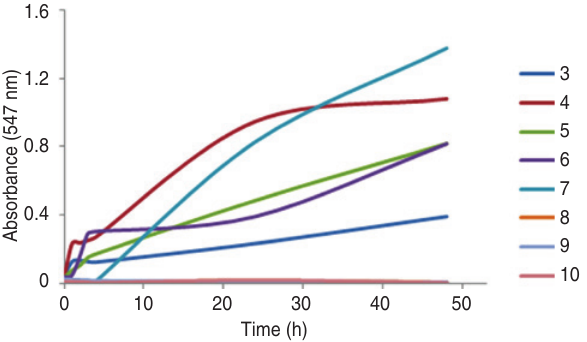
Figure 4: The effect of pH on the synthesis of gold nanoparticles.